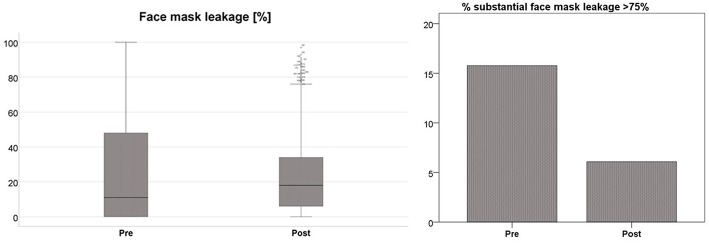
Median face mask leakage [%] before (pre) and after (post) simulation-based training (boxplots, left side; p = 0.414) and incidence [%] of substantial face mask leakage >75% (column chart, right side; p < 0.001) before (pre) and after (post) simulation-based training.